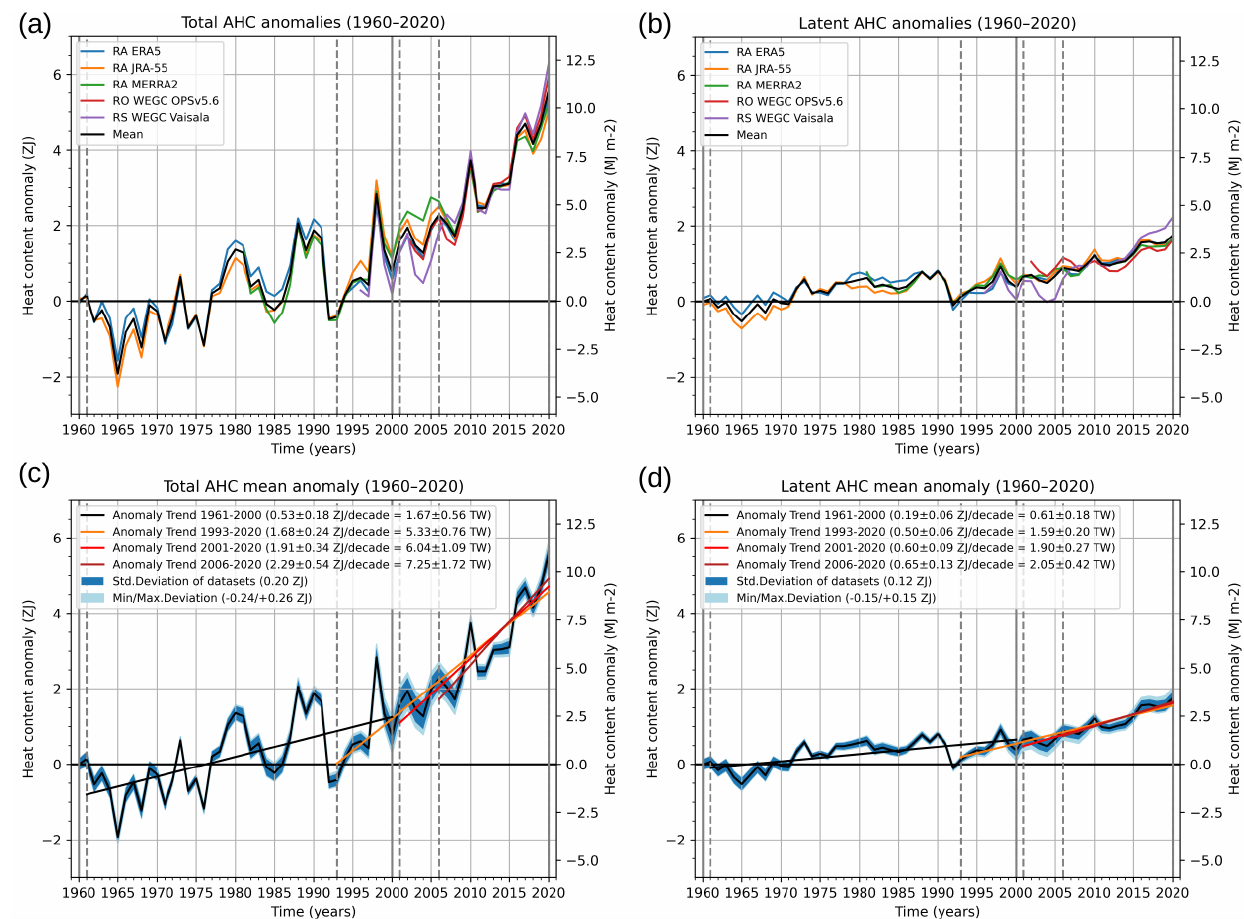
Figure 4. Annual-mean global AHC anomalies from 1960 to 2020 of total AHC (a, c) and latent-only AHC (b, d) , respectively, of three different reanalyses and two different observational datasets shown together with their mean (a, b) and the mean AHC anomaly shown together with four representative AHC trends and ensemble spread measures of its underlying datasets (c, d) . The in-panel legends identify the individual datasets (a, b) and the selected trend periods together with the associated trend values (plus 90% confidence range) and ensemble spread measures (c, d) , with the latter including the time-average standard deviation and minimum/maximum deviations of the individual datasets from the